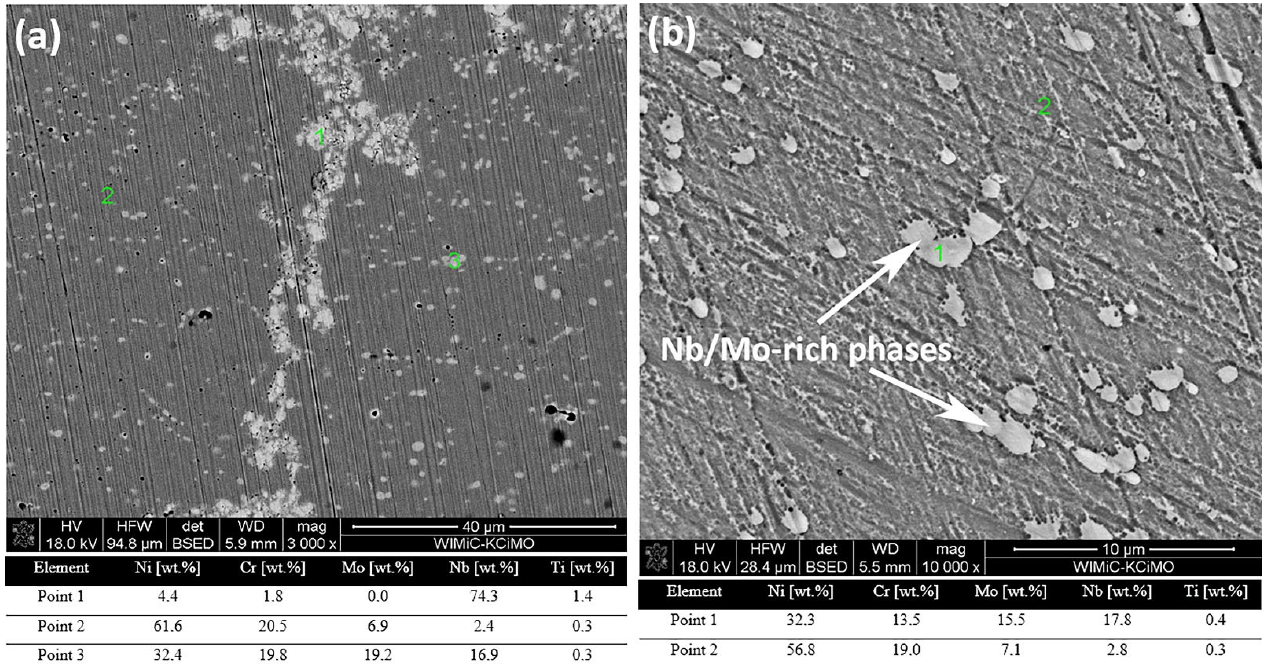
Figure 6. SEM images and EDS point analysis for samples of ( a ) 5% of reinforcement and ( b ) without reinforcement.